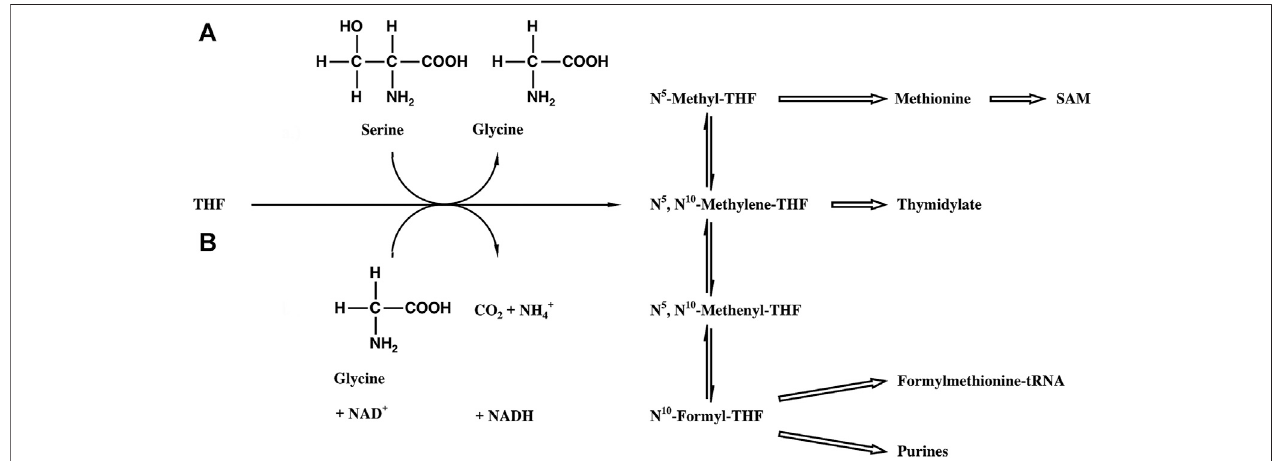
FIGURE 1 | Biosynthetic scheme of the THF-bound C 1 pool. (A) SHMT reaction. (B) Glycine synthase